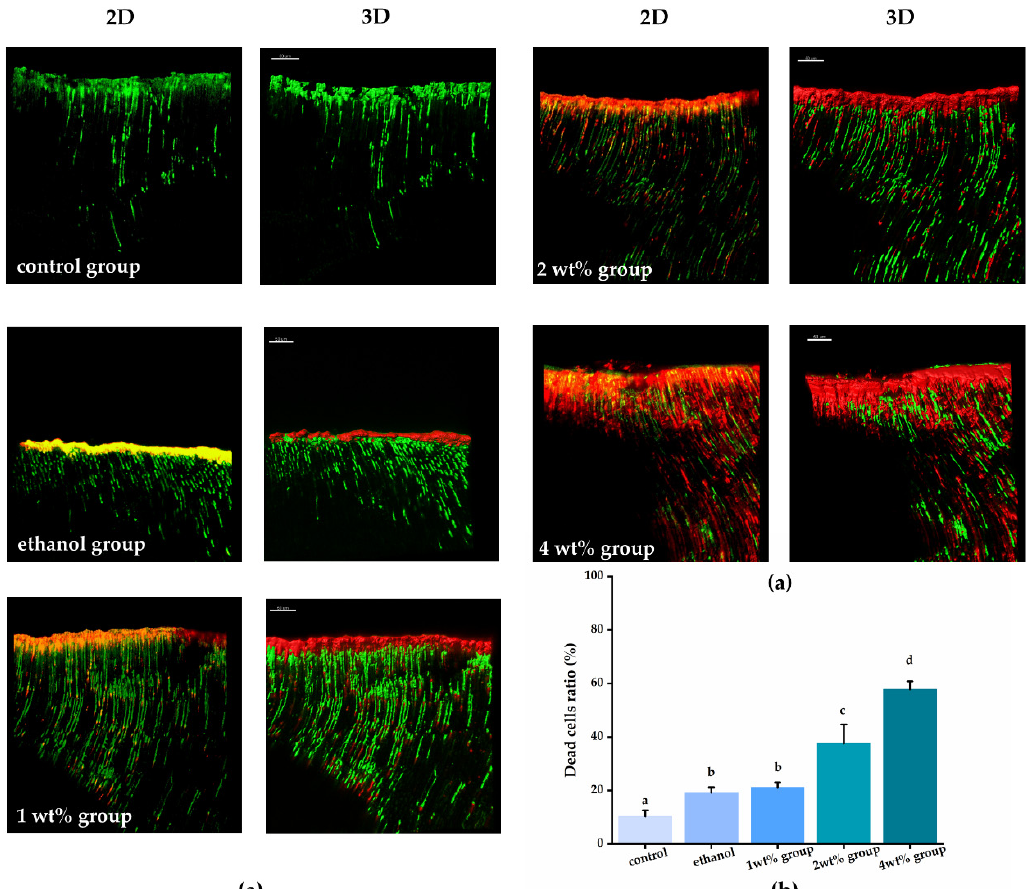
Figure 3. ( a ) Representative CLSM images of E. faecalis biofilms in dentinal tubules treated by different irrigants after live/dead staining and histogram showing dead cell ratio of bacteria biofilms from corresponding groups. For the CLSM images from each group, the image on the left is a 2-dimensional emerged image and the image on the right is a 3- dimensional reconstruction. ( b ) Quantitation data of the percentage of live and dead area, groups with the same letters are not statistically different ( p >